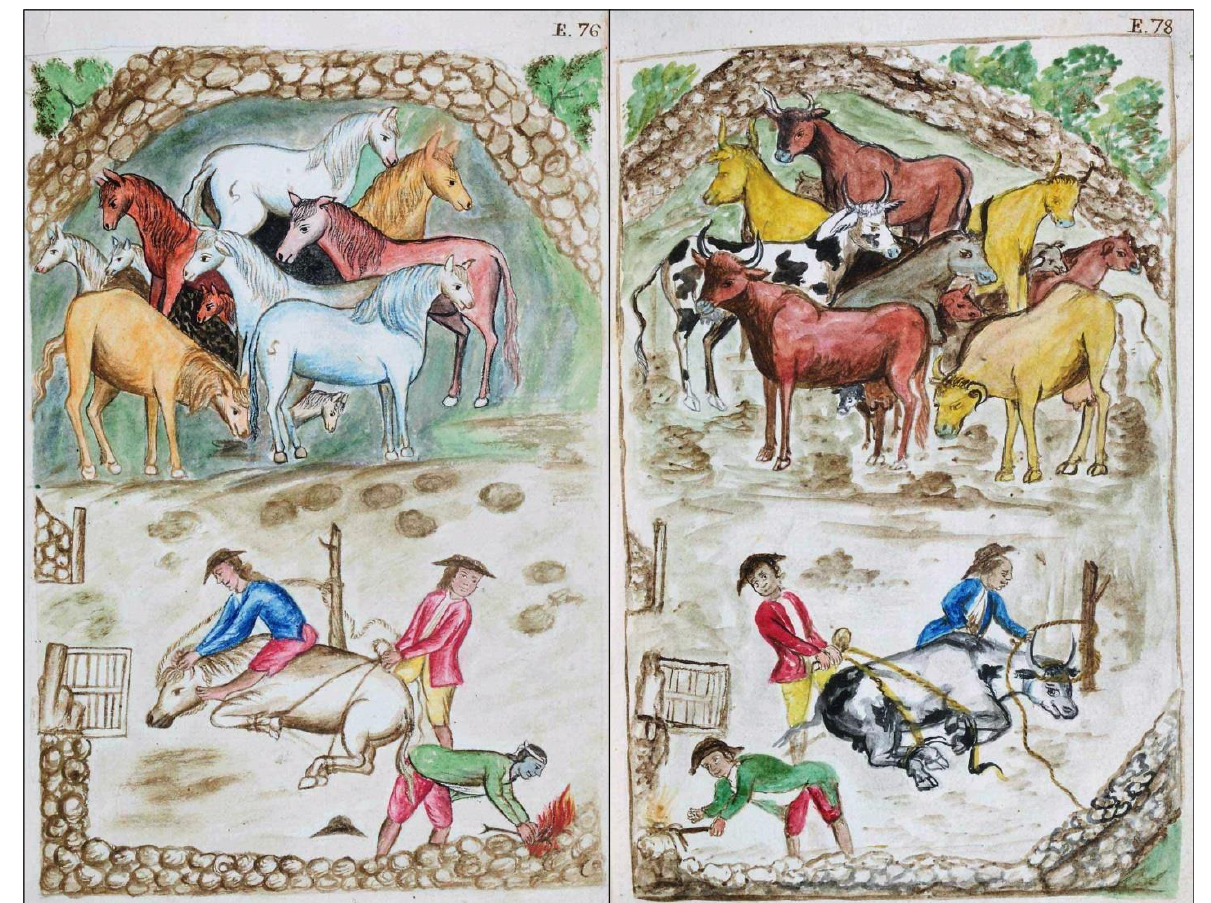
Figure 7. Colonial drawing depicting indigenous Andean branding cattle and horses inside corrals with stone walls. Anonymous watercolours from the 18th century. Public domain images from the Biblioteca Real, Madrid. Martínez Compañón, Trujillo del Perú, V.II /334/ E.76 y E.78. IBIS. Base de datos del Patrimonio Bibliográfico de Patrimonio Nacional.